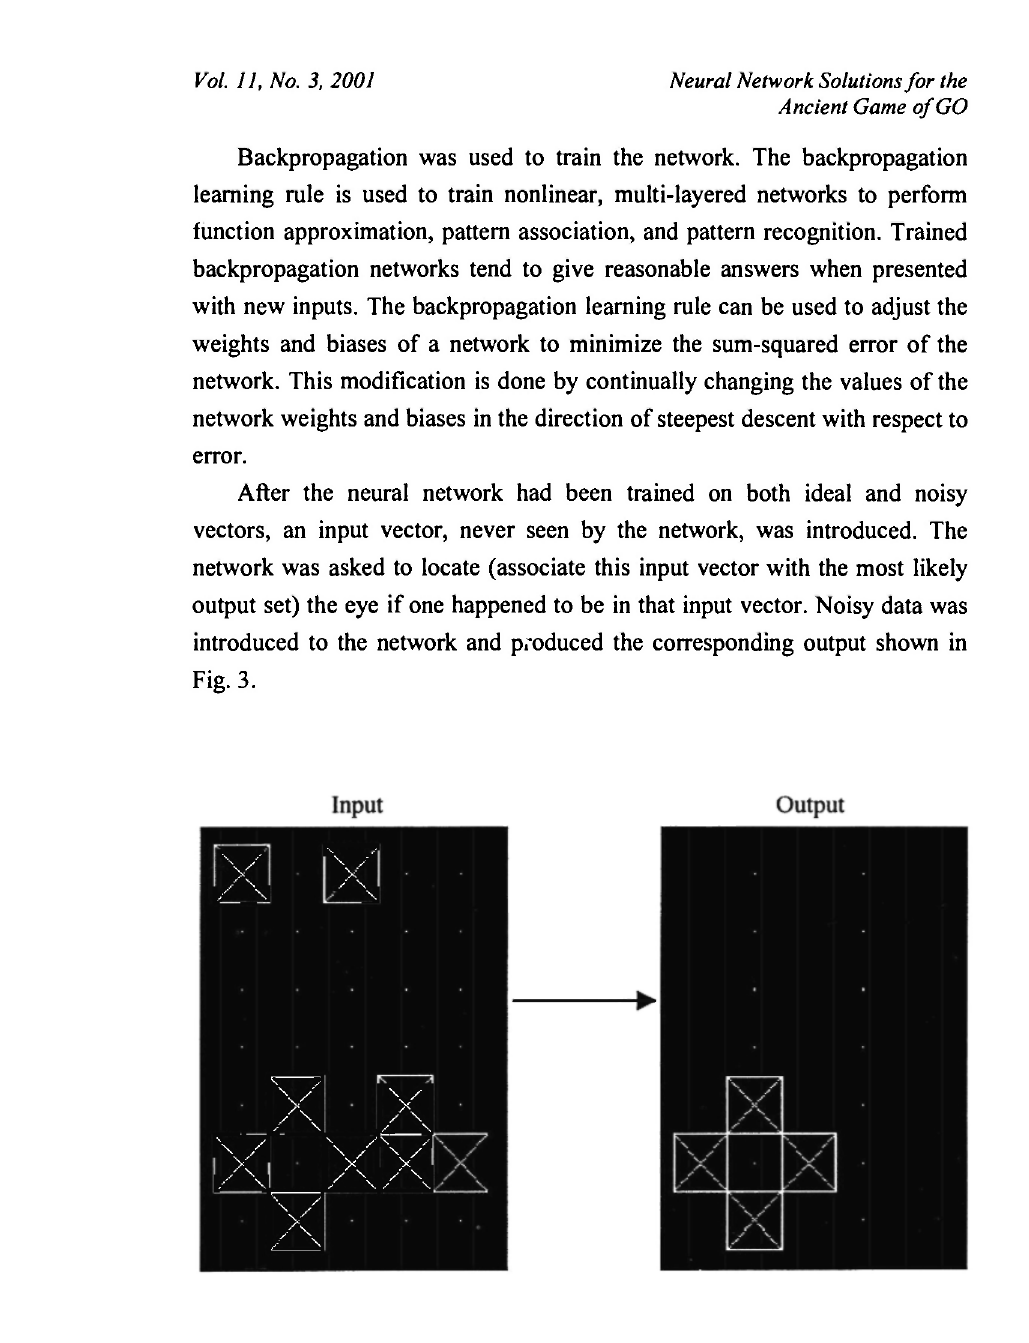
Fig. 3: Input noisy data and its corresponding output as produced through the back- propagation